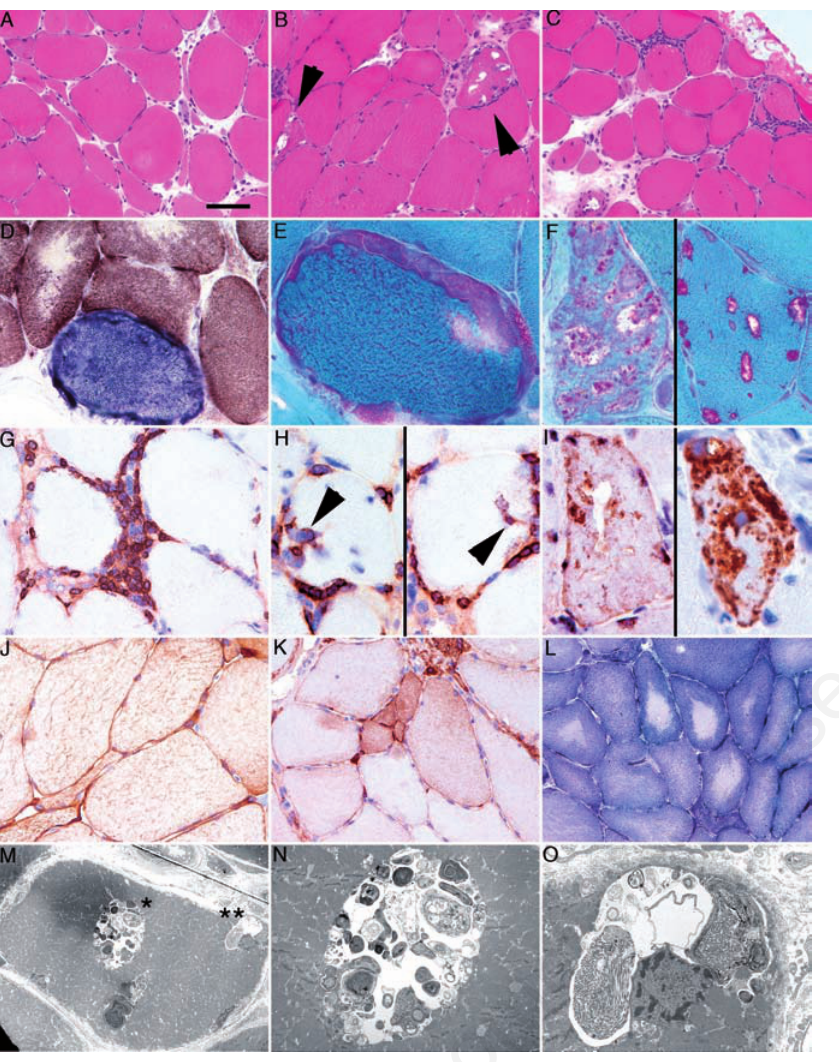
Figure 1. Muscle biopsy from the right lateral vastus muscle showing atrophic fibers with caliber changes (A), many rimmed vacuoles together with endomysial inflammatory infil- trates (B, C), COX negative-fibers (D) and a single RRF with rimmed-vacuoles (E, F). Inflammatory infiltrates consisted mainly of CD3-positive T-cells, including CD8-posi- tive cytotoxic T-cells with invasion of intact muscle fibers (G, H). SMI-31 (neurofilament) and p62 (I) showed immunoreactivity in the vacuoles. Signs of a neurogenic muscle lesion with fiber-type grouping and upregulation of NCAM were noted (K). Ultrastructural examination revealed fibers with autophagic vacuoles with sequestered cytoplasmic organelles and degradation products (M, N,